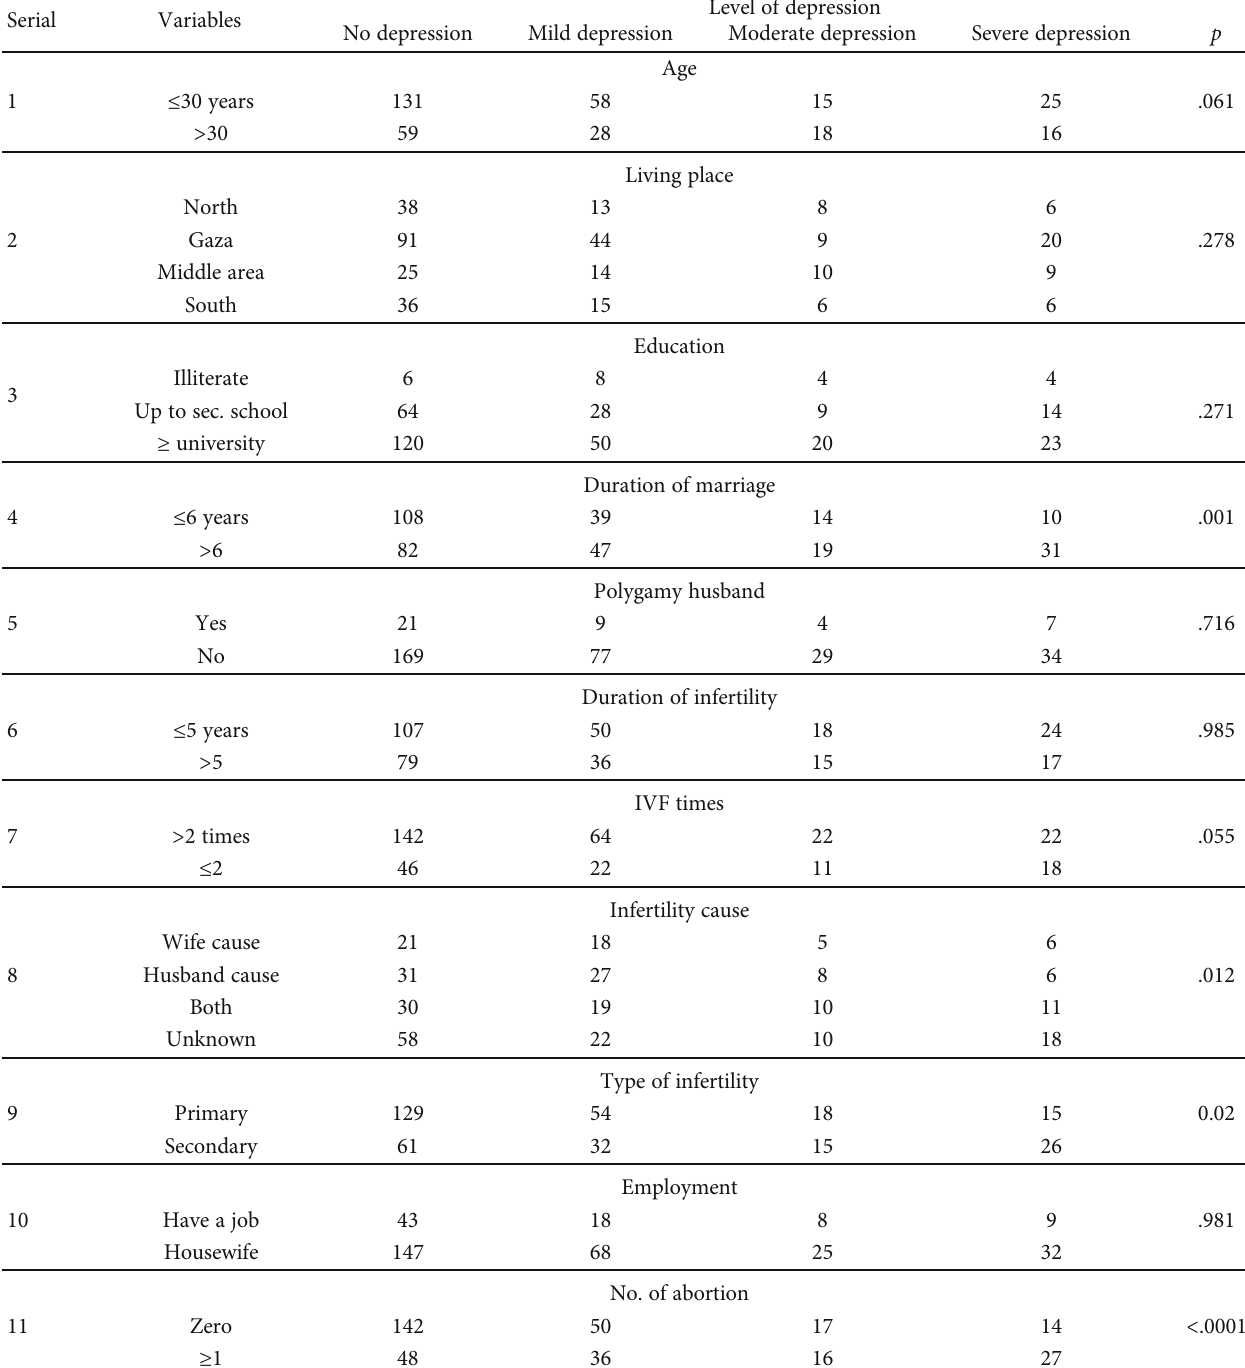
Table 2: Comparison of severity of depression symptoms with regard to participants ’